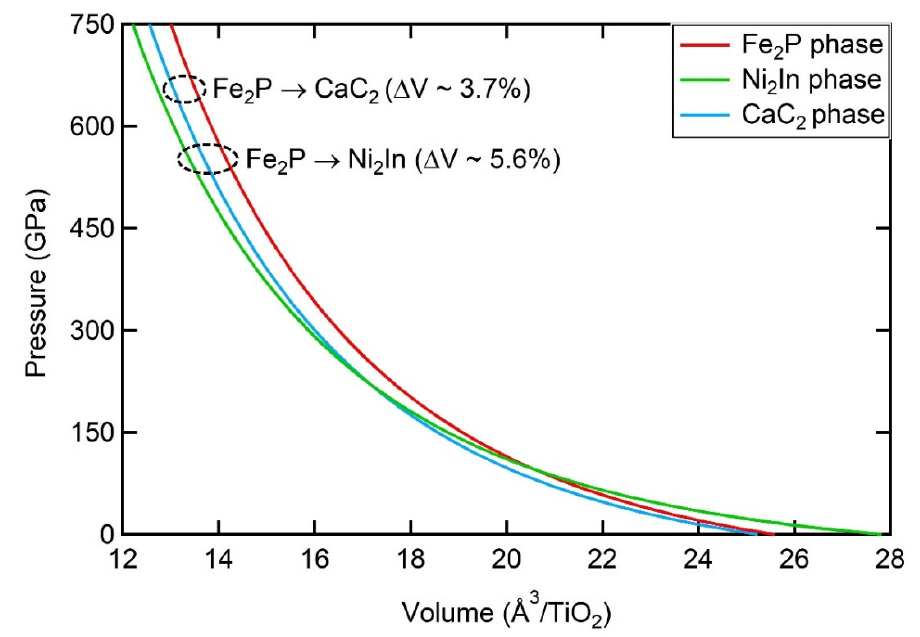
Figure 2. Pressure versus volume of TiO 2 phases as determined by GGA calculations using BM ‐ EOS [57]. The dashed circles show the large volume reduction across the Fe 2 P → Ni 2 In and Fe 2 P → CaC 2